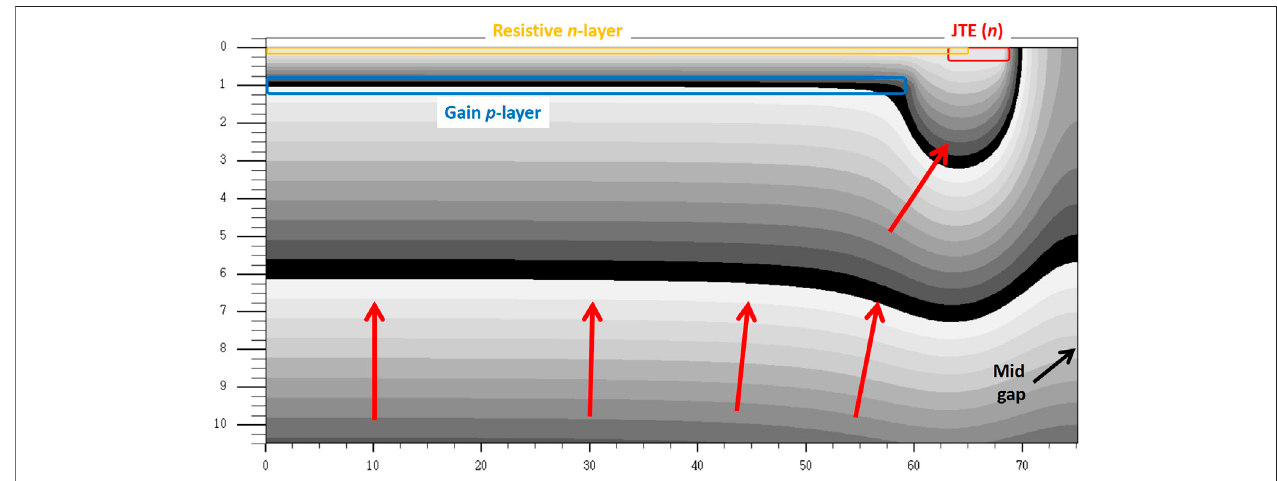
FIGURE7| MapoftheelectrostaticpotentialintheexampleofLGADsimulated.Onlythepartofthestructure totheleftofthemidgapisshown.RedArrowsshow the trajectories of electrons.